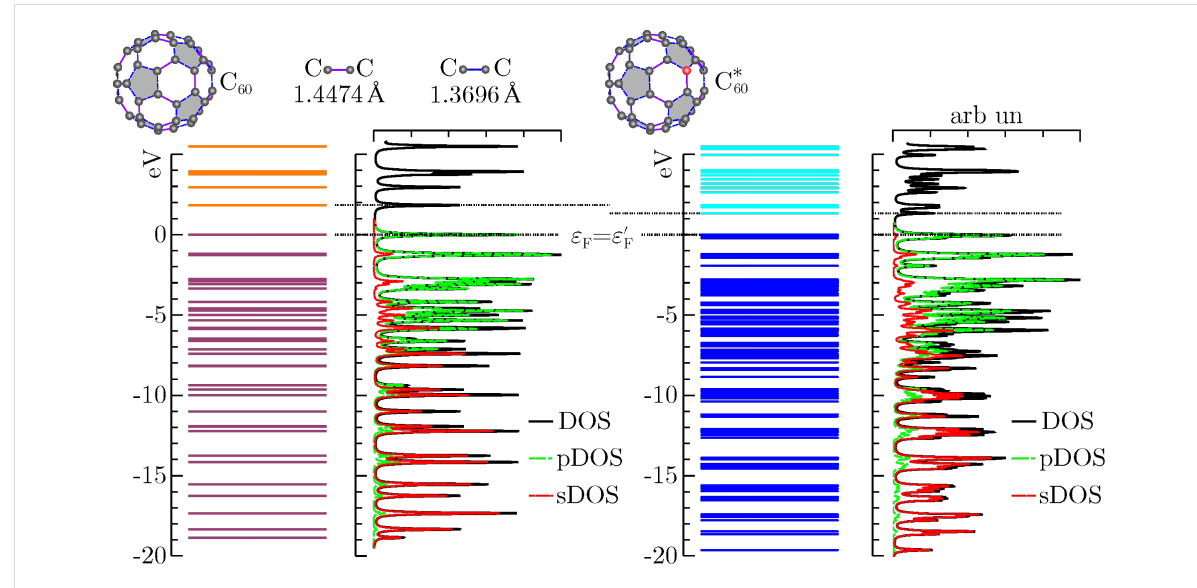
Figure 1: Valence levels and (broadened) DOS for the neutral (C 60 ) and ionized ( ) fullerene molecules, as computed with the DFT approach outlined in the main text. In C 60 the projected density of s and p states contribute for 44.2% and 55.3% of the occupied DOS, respectively. In the s-DOS and p-DOS contributions change to 51.1% and 48.8%, respectively. The residual part (not shown) is left to the projected density of polarized